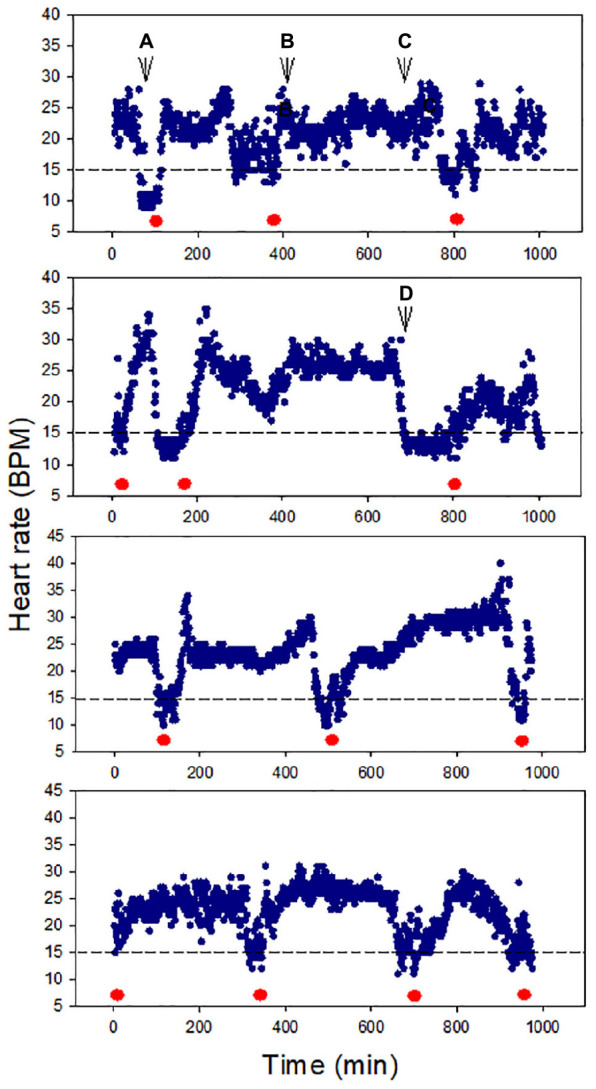
Heart rate (HR) modulation in four snails during 16 h air exposure (27 ± 0.2°C). All snails showed distinct cycles of depression and elevation of heart rate, including bradycardia (defined here as 15 BPM, red markers). Harmonic heart beating was observed throughout the 16 h period. Letters pinpoint where cardiograms shown in Figure 3 were collected.